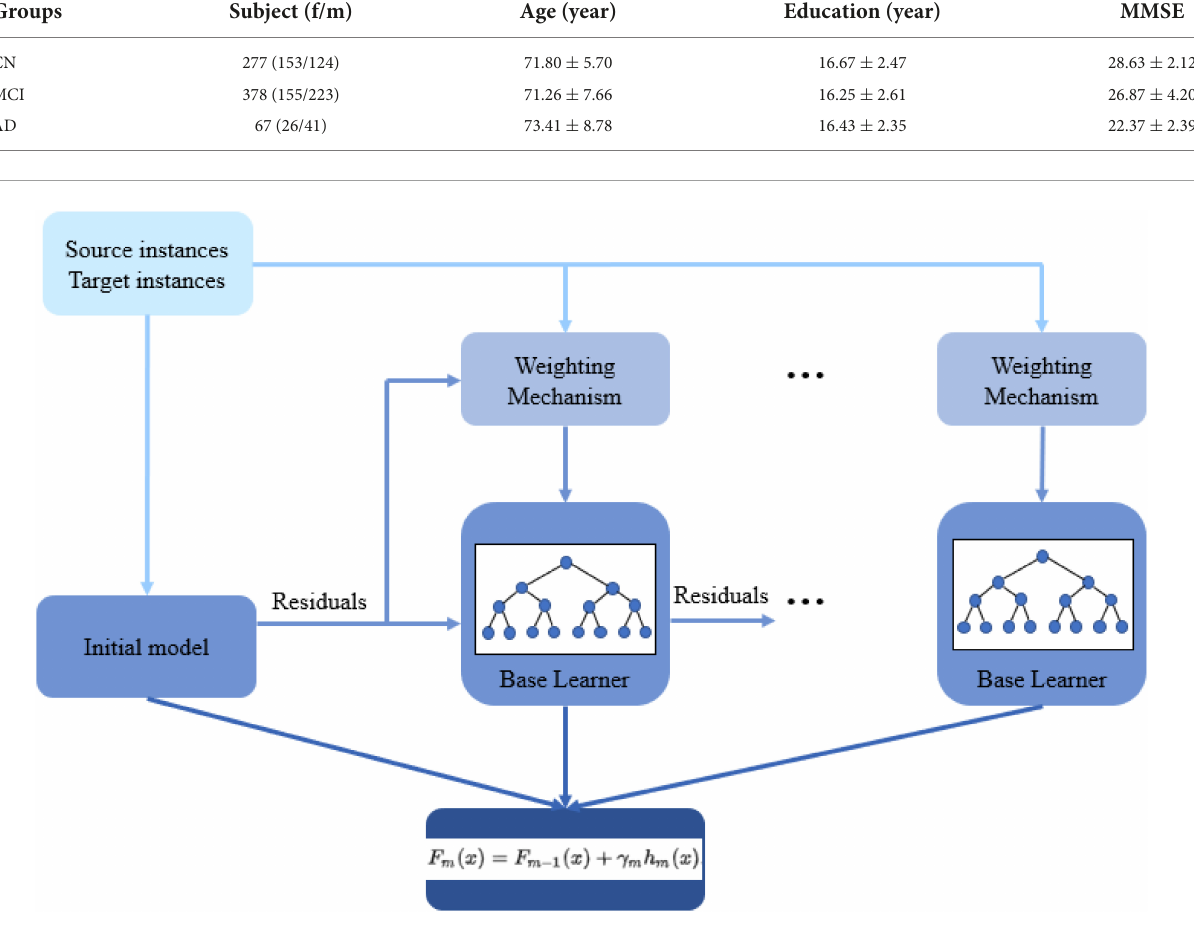
FIGURE1 The structure of the proposed gradient boosting-based transfer learning approach (TrGB).